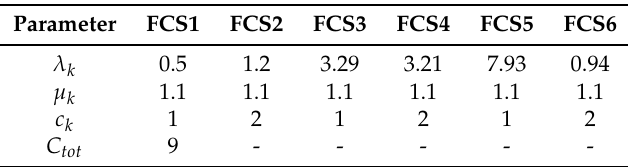
Table 4. Current FCS parameters.